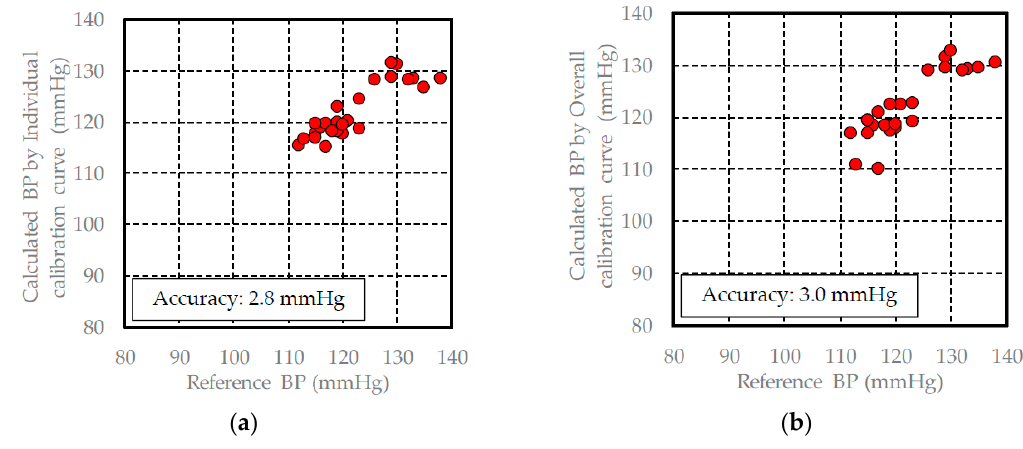
Figure 9. Validation results of the blood pressure in subject B: ( a ) calculated blood pressure results using the individual calibration curve; ( b ) calculated blood pressure results using the overall calibration curve.